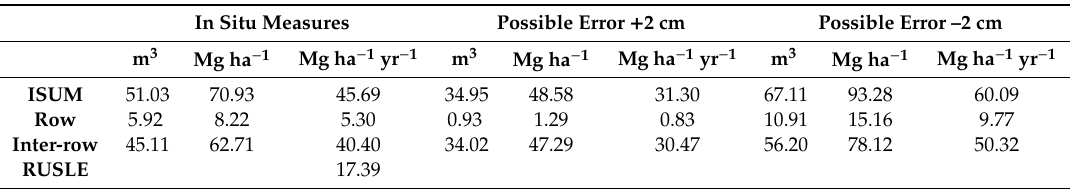
Table 4. Soil erosion estimation and comparison between the ISUM (Improved Stock Unearthing Method), row and inter-row areas, and the RUSLE (Revised Universal Soil Loss